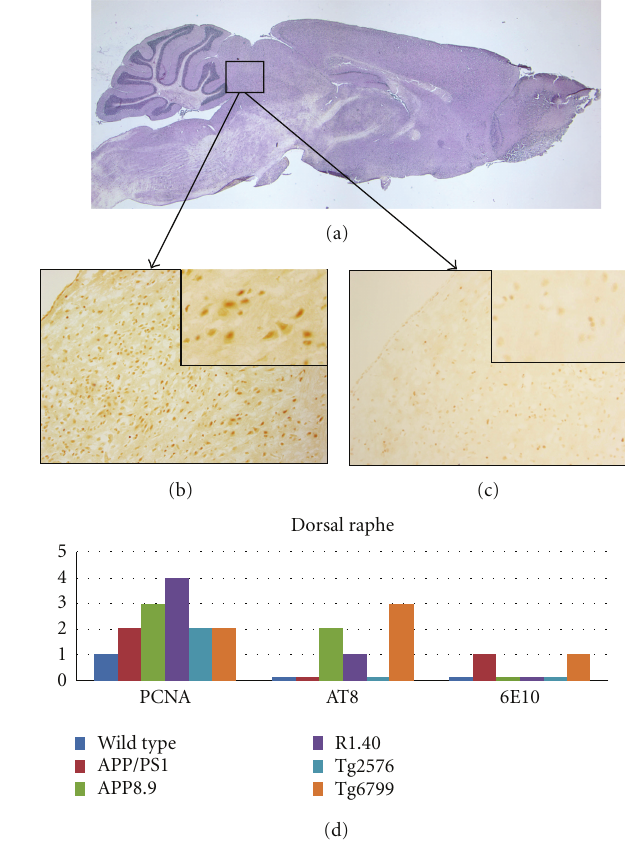
Figure 2: Comparison among the mouse lines studied with respect to the presence of cell cycle events (PCNA), tau-phosphorylation (AT8), and beta-amyloid plaque deposition (6E10) in the dorsal raphe. (a) Sagittal section of a wild-type mouse brain indicating the approximate location of the raphe in our preparations. (b) PCNA-positive neurons are illustrated by their appearance in this representative section from the R1.40 mouse model. (c) Minor PCNA immunostaining is seen in wild-type mice as illustrated in this representative micrograph. The insets in both (b) and (c) are representative fields at higher magnification to illustrate the qualities of the cell cycle staining. (d) Quantification of the extent of